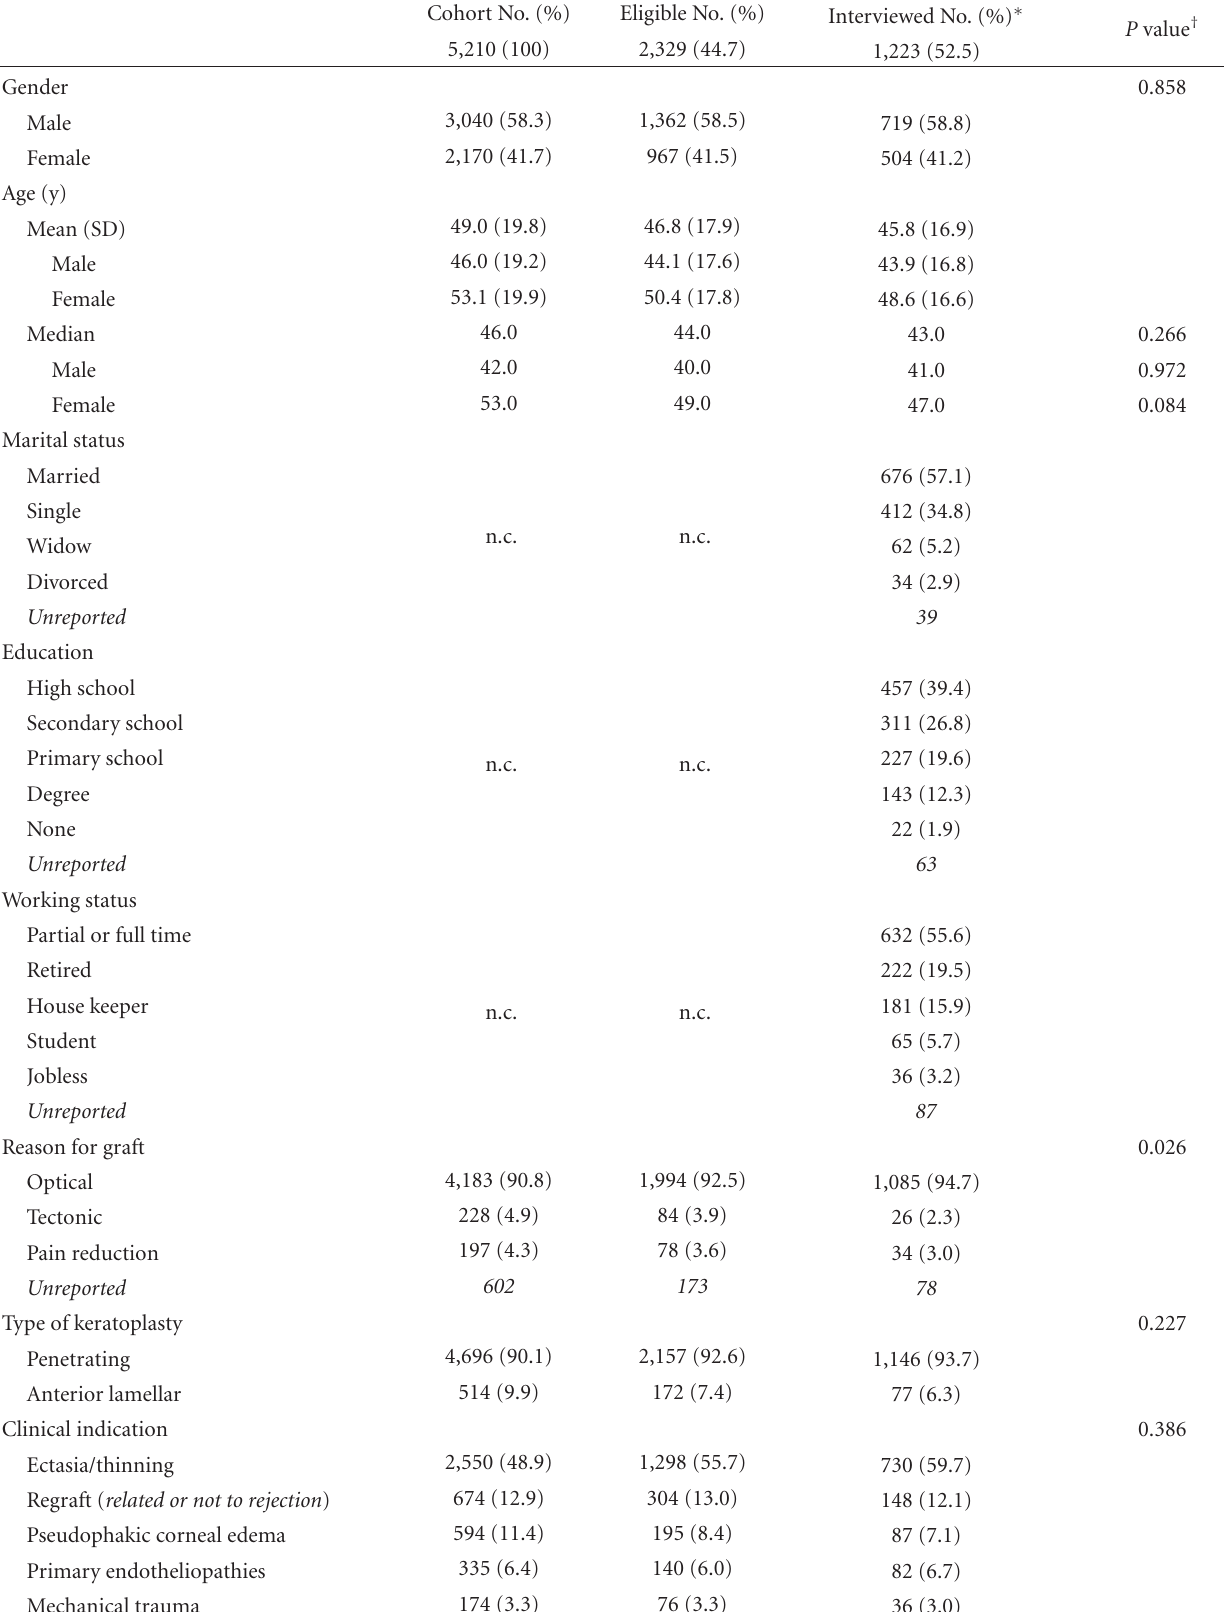
Table 1: Sociodemographic and clinical characteristics of